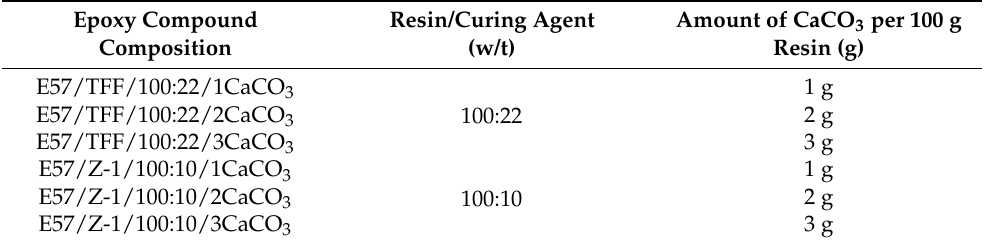
Table 3. Compositions of epoxy compounds produced with and without calcium carbonate filler. Epoxy Compound Resin/Curing Agent Composition